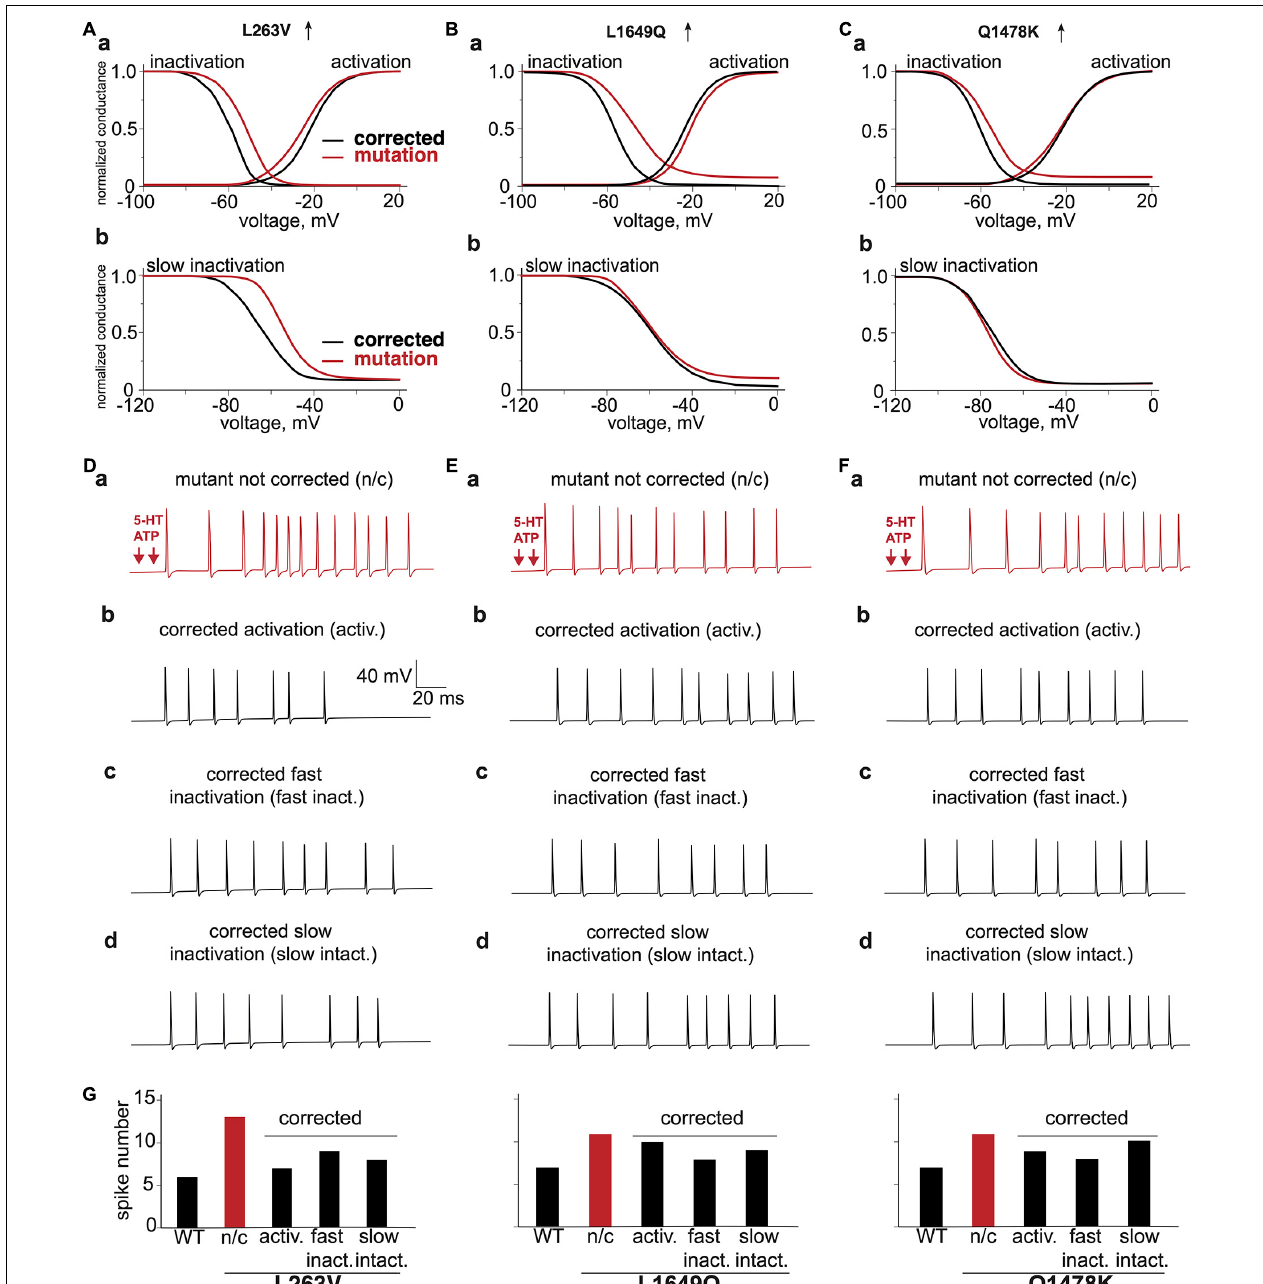
FIGURE 7 | The virtual correction of the abnormal phenotype via modification of voltage characteristics of mutated channels. The comparison of voltage dependence of corrected activation, fast inactivation and mutation (Aa) L263V, (Ba) L1649Q, (Ca) Q1478K. The comparison of voltage dependence of corrected slow inactivation and mutation (Ab) L263V, (Bb) L1649Q, and (Cb) Q1478K. (Da) L263V mutant fiber activated by ATP + 5-HT release events, (Db) with corrected activation, (Dc) with corrected fast inactivation, (Dd) with corrected slow inactivation. (Ea) L1649Q mutant fiber activated by ATP + 5-HT release events, (Eb) with corrected activation, (Ec) with corrected fast inactivation, (Ed) with corrected slow inactivation. (Fa) Q1478K mutant fiber activated by ATP + 5-HT release events, (Fb) with corrected activation, (Fc) with corrected fast inactivation, (Fd) with corrected slow inactivation. (G) The spike number of WT fiber and L263V, L1649Q, and Q1478K mutations with correction of activation and inactivation. ATP signaling is limited by partial hydrolysis and 5-HT signals are reduced by specific uptake.